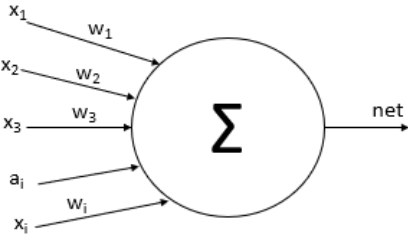
Figure 6. Basic artificial